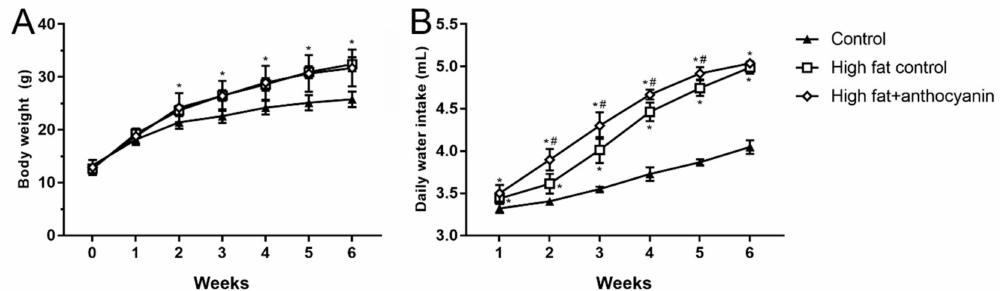
Figure 2. E ff ect of chronic anthocyanin treatment on body weight (Panel A ) and daily water intake (Panel B ). The * indicates a significant di ff erence ( p < 0.05) from the control group. The # indicates a significant di ff erence ( p < 0.05) between the high fat control and the high fat + anthocyanin